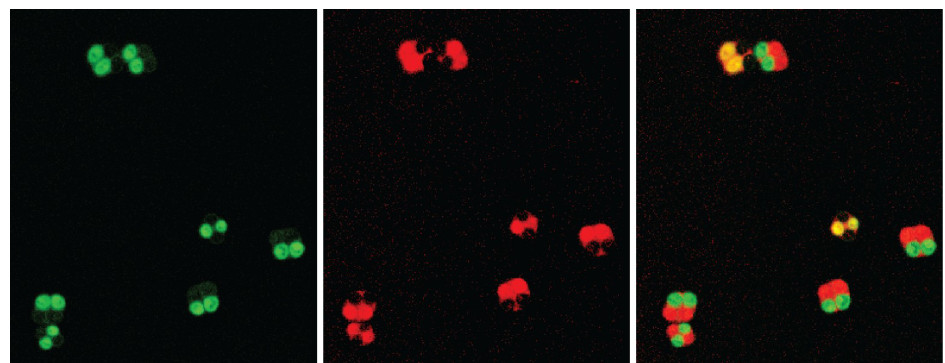
Fig 1. Spore-autonomous expression of fluorescent proteins under the DIT1 promoter. Hybrid diploids were created by crossing a MAT α strain with a single chromosome marked with pDIT1 _ tdTomato with a MATa strain marked with pDIT1 _ GFP at the same position on the same chromosome. Sporulation of these diploids generates asci containing 4 spores (tetrads). Correct segregation of homologous chromosomes during meiosis I results in tetrads containing 2 GFP-expressing spores and 2 tdTomato-expressing spores. Under meiosis I nondisjunction, homologous chromosomes fail to segregate, resulting in 2 spores expressing both GFP and tdTomato and 2 spores expressing neither. Left panel = GFP fluorescence; middle panel = tdTomato fluorescence; right panel = overlay. Here, we show 7 tetrads produced by sporulating YDP1480 × YDP1559 hybrid diploids, 5 of which show correct segregation and 2 of which show nondisjunction (yellow spores in overlay). GFP, green fluorescent protein; tdTomato, tandem dimer Tomato fluorescent protein.